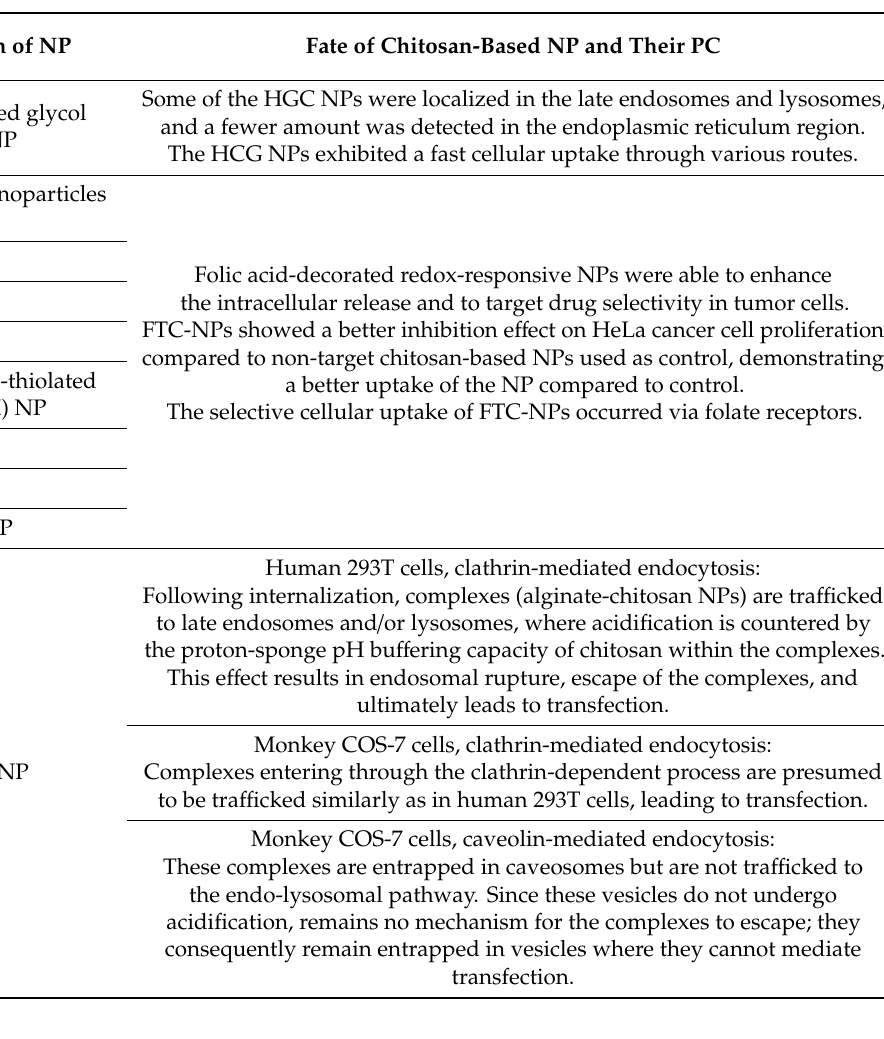
Table 2. The fate of chitosan-based NPs and their PC in various biological fluids and